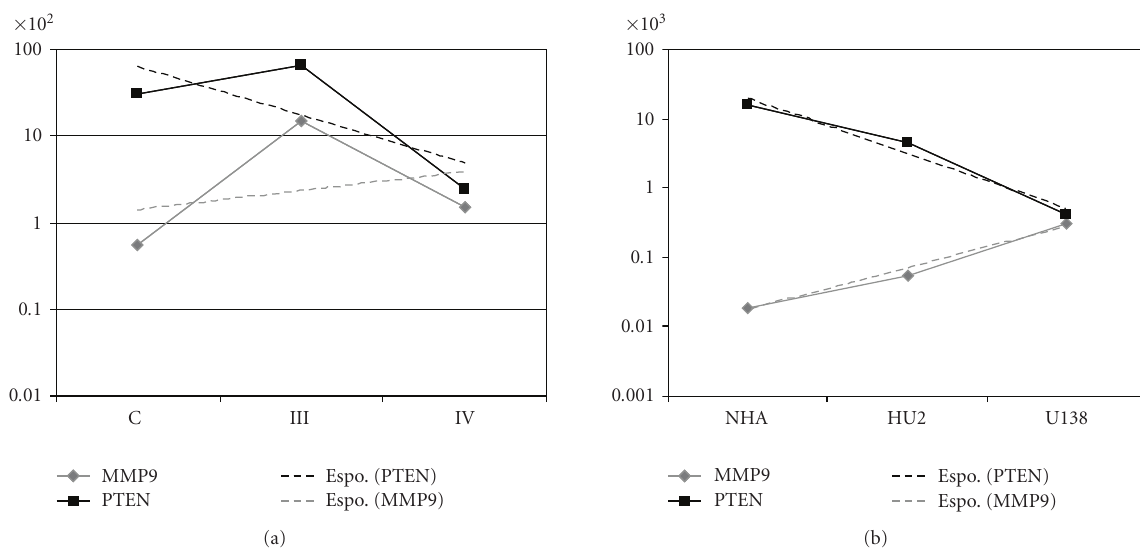
Figure 6: Statistical trends of PTEN (black dotted line) and MMP9 (grey dotted line) expression in control (C), anaplastic astrocytomas (III) and glioblastoma multiforme (IV) specimens (Panel A), and in normal human astrocytes (NHA), glioma PRT-HU2 (HU2), and U138-MG (U138) cells (Panel B). Trends are calculated using average quantitative expression of PTEN and MMP9 , and adopting exponential (Espo) models of prediction as follows: PTEN (C, III, IV average expression samples), y = 2148 e − 1 . 29x ; MMP9 (C, III, IV), y = 83716 e 0 . 50x ; PTEN (NHA, HU2, U138), y = 118596 e − 1 . 82x ; MMP9 (NHA, HU2, U138), y = 42439 e 1 . 40x